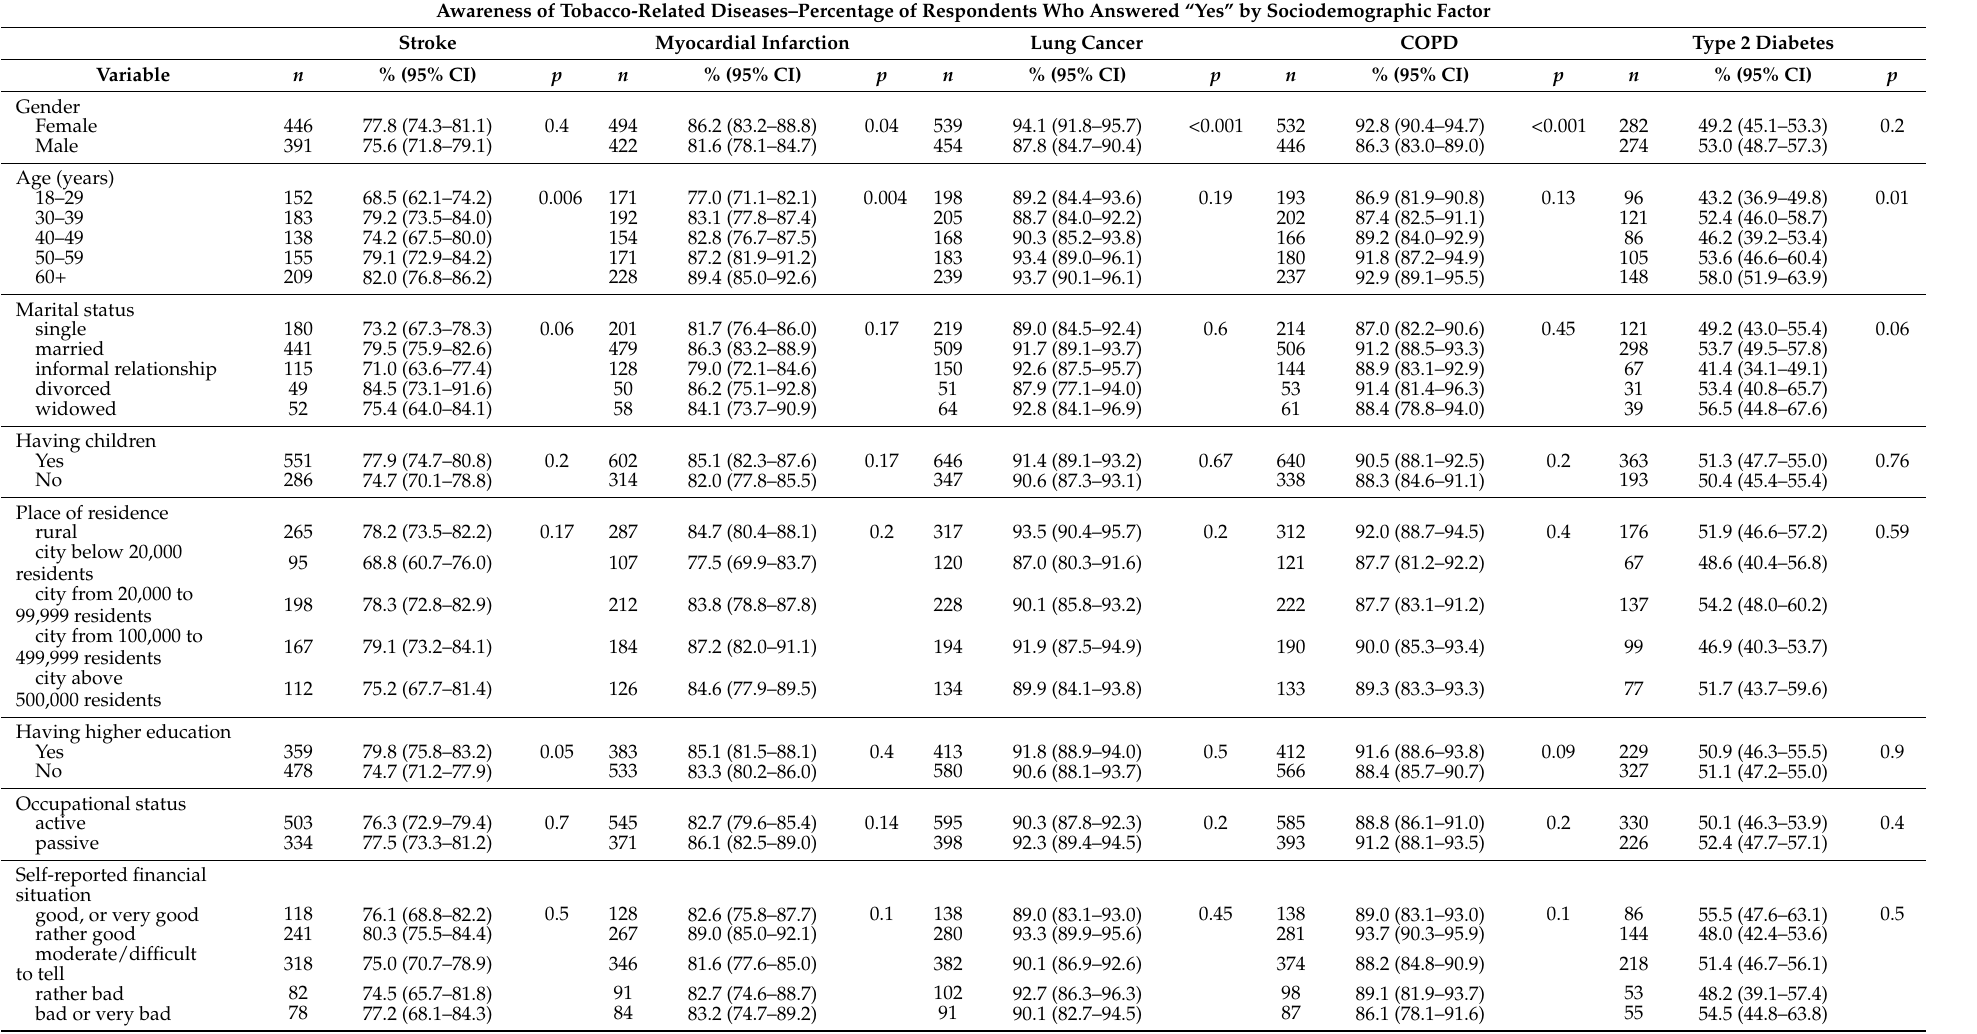
Table 3. Awareness of tobacco-related diseases by sociodemographic factors ( n =